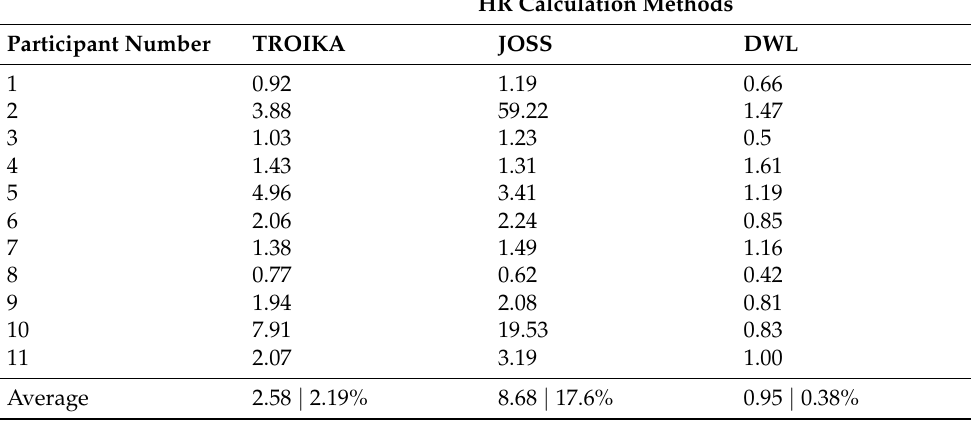
Table 3. MAEP in % for all eleven (11) experimental participants, using DWL, TROIKA, and JOSS (ideal MAEP is 0%). The last row shows the MAEP average of all eleven (11) participants shown as “mean | standard